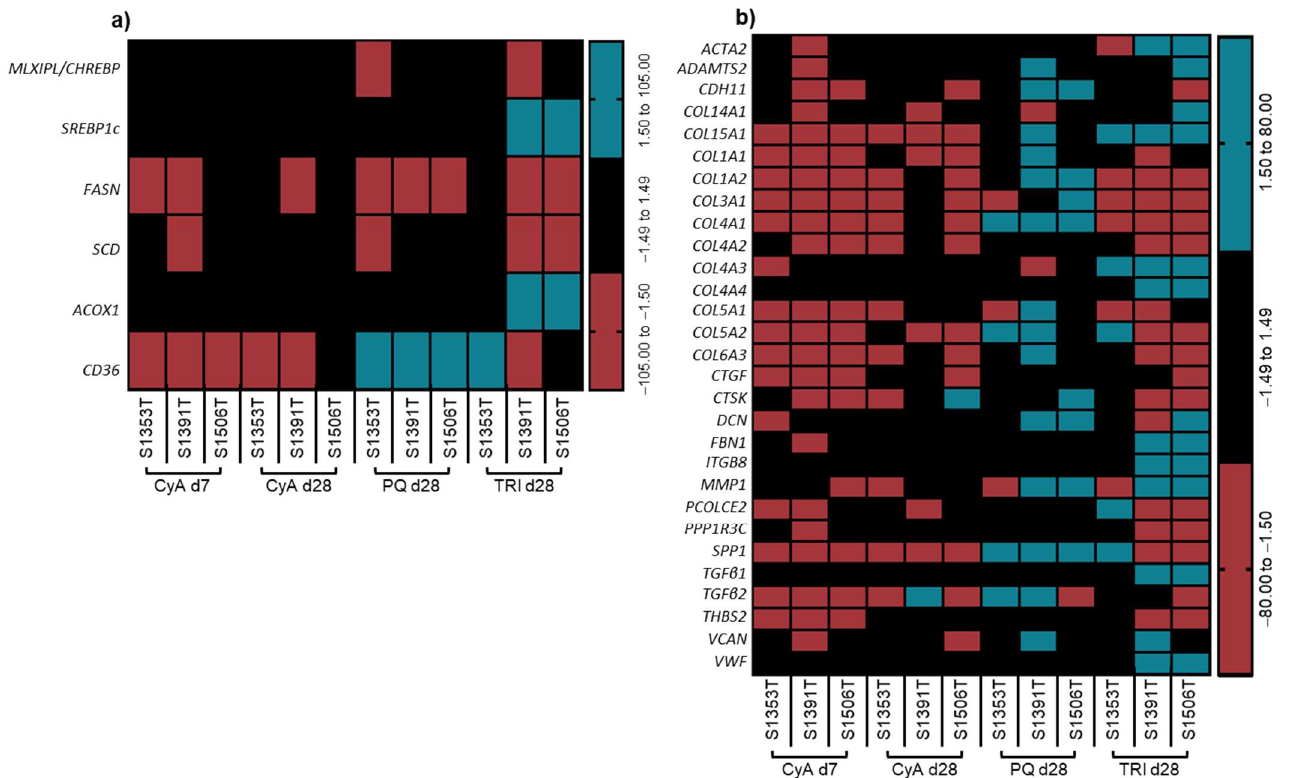
Figure 6. Relative expression of genes related to ( a ) liver steatosis and ( b ) liver fibrosis. The effects of a 7- and 28-day exposure to CyA 5 μM and of a 28-day exposure to PQ 2 μM and TRI 100 μM were assessed by microarray analysis in at least 75 spheroids from each PHH donor. Absolute fold changes in gene expression above 1.5 were considered significant. All the gene names are listed in Table S2 in the supplementary materials. CyA—cyclosporine-A; d—day; PHH—primary human hepatocytes; PQ—paraquat; TRI—triclosan.